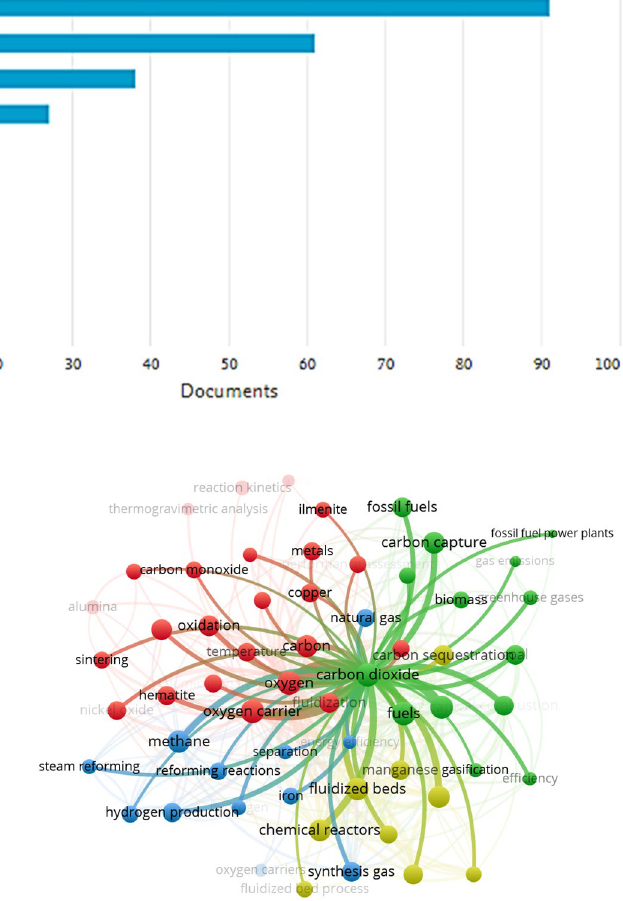
Fig. 8 Documents by Country or Territory (Source: www. scopus. com)